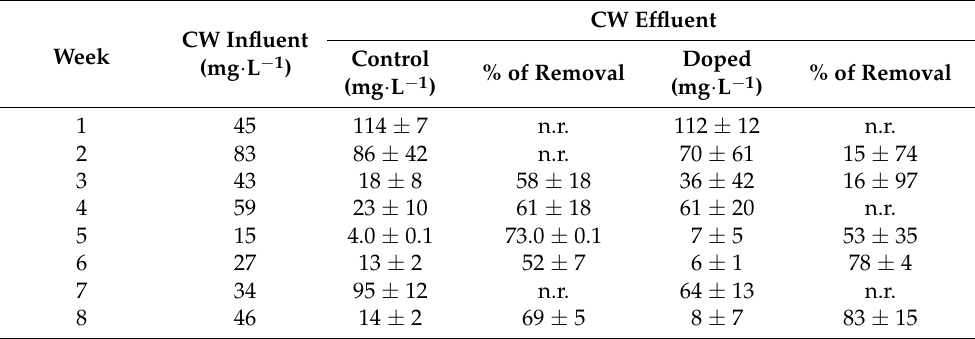
Table 1. Concentration of chemical oxygen demand (COD) (mg O 2 l − 1 water) in constructed wetlands (CWs) influents and effluent (mean ± standard deviation, n = 3) and percentage of removal (%, mean ± standard deviation, n = 3) in CWs irrigated along eight weeks with Ribeira de Joane water not doped (control) or doped with nonylphenol (NP) and octylphenol (OP). n.r. indicates that there was no COD removal in CWs system.